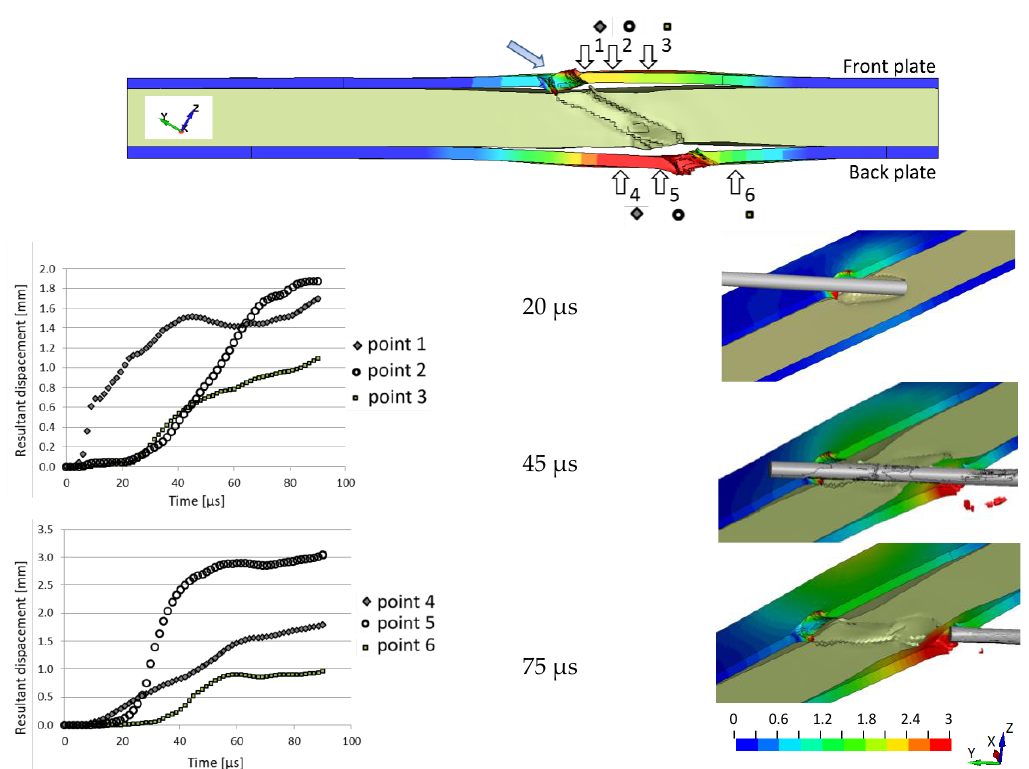
Figure 13. The resultant displacement of the side steel plates . Despite not accurately identified values of the deformation of the plate, the simula- tion generally predicts correctly modelled shapes of the deformed plates. On the cross- section of the perforated target, six points are chosen on the front (1 – 3) and back faces (4 – 6) of the steel plates. The dependences of the resultant displacement in time indicate that both plates start to deform already at 20 µs of the penetration process when the rubber begins to expand (Figure 8). The projectile perforated the first plate and is in the middle of the rubber layer, the expanding of which starts to affect the back plate. Point 1 starts to move a bit earlier because of the proximity of the entry hole of the perforation channel. Its resultant displacement (1.6 mm) is almost as high as its value read for point 2 (1.8 mm), located in the first plate ’ s most bent zone. Point 2 reaches the plateau of its displacement in its maximum value when the projectile leaves the target (close to 80 µs). The bottom plate deforms more than the front plate. Points 4 and 5, which are beneath the rod nose, are affected more than point 6 above it (the resultant displacement of which is about 1 mm). Point 5, close to the crater of the perforation channel, reaches 3 mm of the resultant displacement. This maximum value is obtained when the rod is no longer in contact with that side of the exit hole.